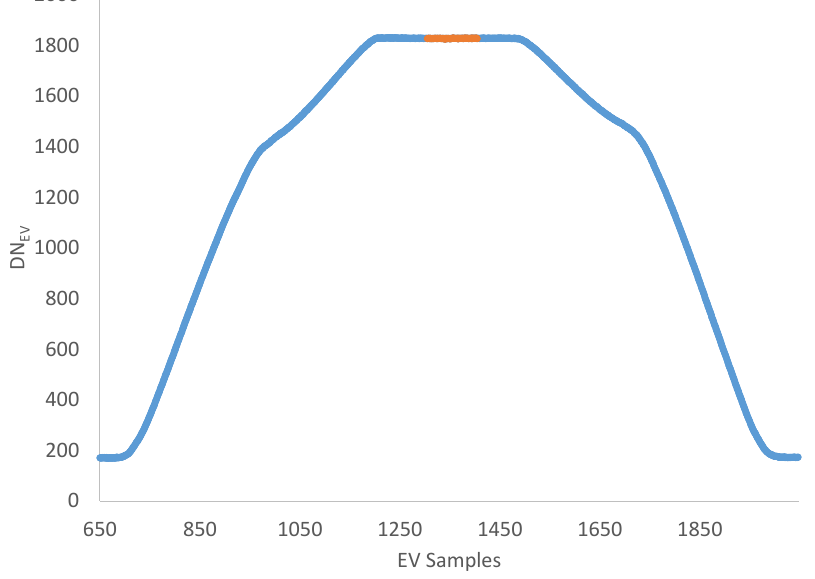
Figure 3. Band M15 DN Response to the LABB Source during the RVS Test (the orange points correspond to the RVS data used during processing).